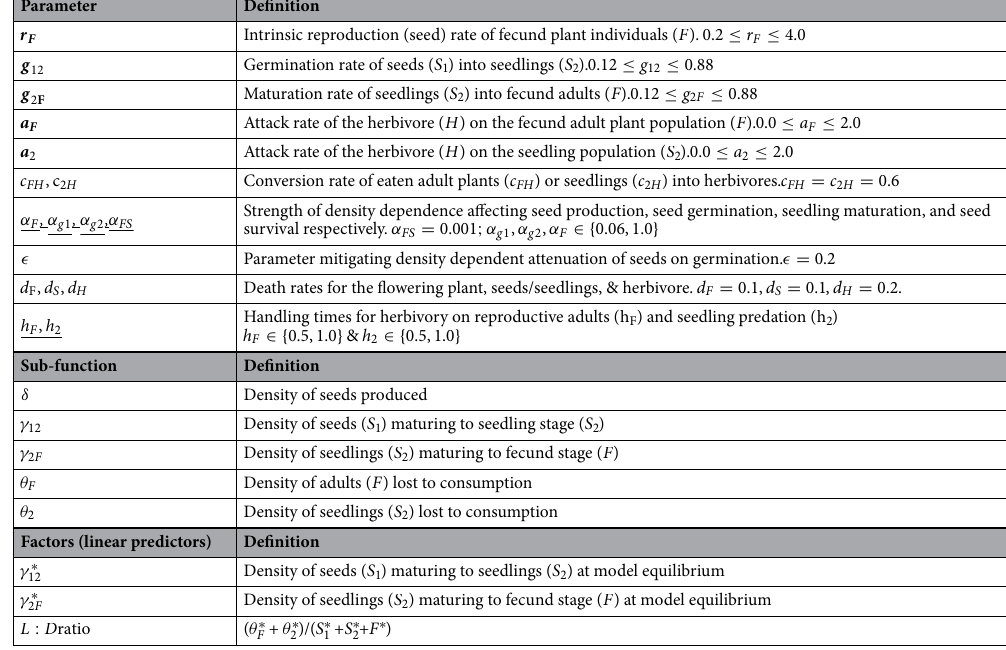
Table 1. Model parameters, sub-functions, and ecological factors. Parameter descriptions include values used in numerical analysis. Text formatted parameters indicate varied parameters during parameter sweeps. Bold highlighted parameters indicate parameters whose value range was varied in factorial parameter sweeps (see Appendix S1.3) for analysis via random forest. Underline highlighted parameters were varied as part of sensitivity analysis. Note, for each simulation α g 1 = α g 2 = α F . All parameter rates are per capita. Note, the 5 bold highlighted parameters were used as input features in our random forests. Also note, F ∗ , S ∗ 1 , and S ∗ 2 indicate equilibrium values of our time dependent variables. Similarly, θ ∗ F and θ ∗ 2 indicate density of adults ( F ) and seedlings ( S 2 ) lost to consumption respectively at model